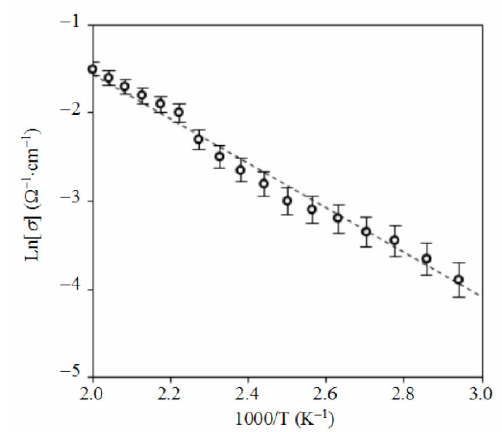
Fig. 3 SEM image of the prepared sample. The particle size is about 35 nm.